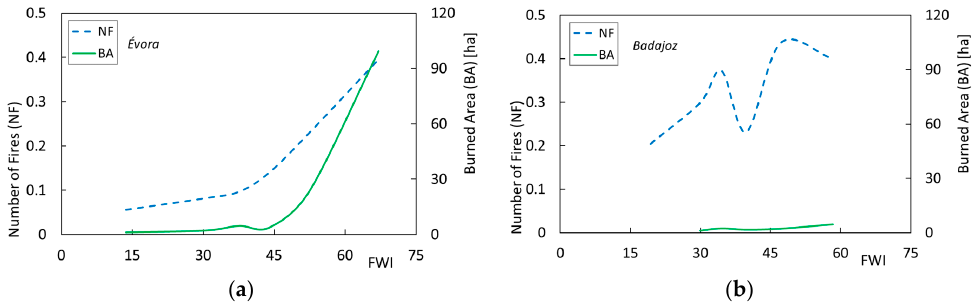
Figure A10. Average number of daily fires (NF) and burned area (BA) as a function of FWI for: ( a ) the Portuguese District of É vora and ( b ) the Spanish Province of